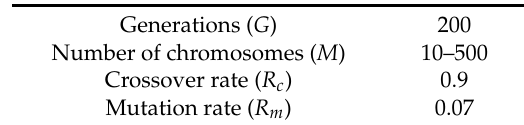
Table 4. Simulation parameters in